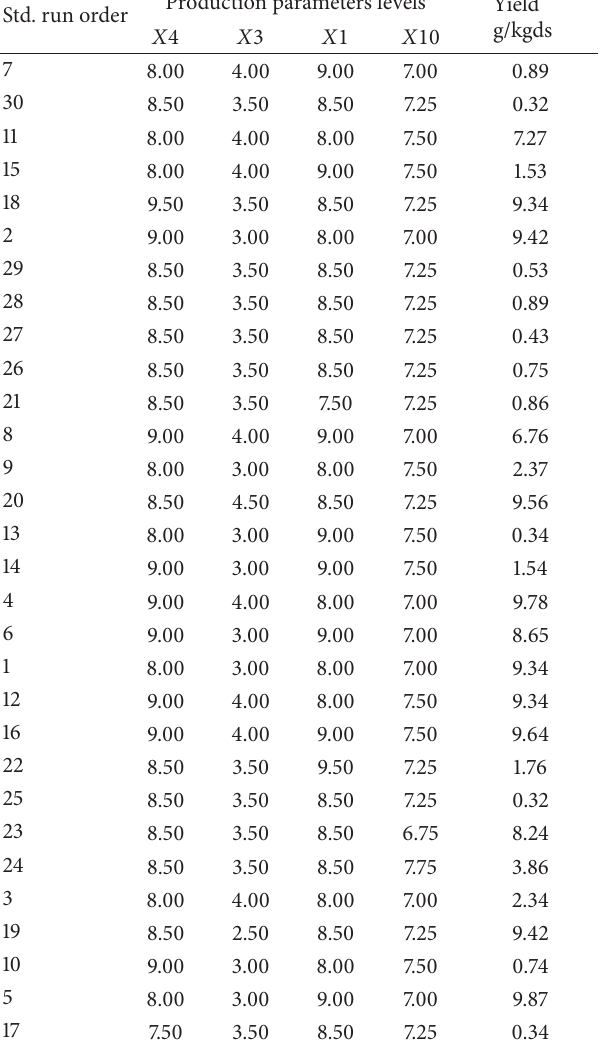
Table 5: Experimental design and results using central composite